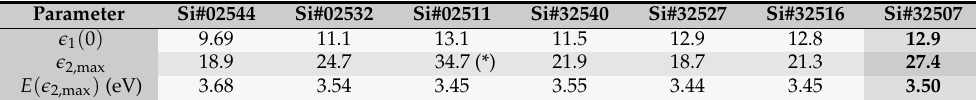
Table 2. The obtained values for three dielectric-constant parameters (cid:101) 1 ( 0 ) , (cid:101) 2,max , and E ( (cid:101) 2,max ) (see Figure 5), for the seven a -Si specimens under analysis, are all listed in this table. The fitted values have been found by adopting the holomorphic ATLU